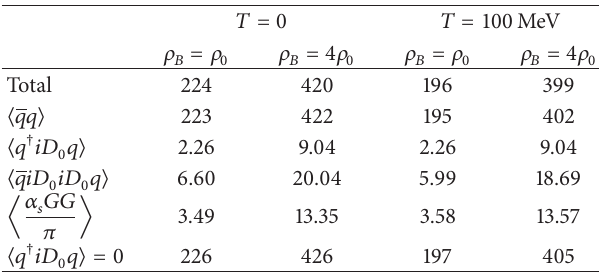
Table 1: The following table gives the values of mass shift of scalar mesons 𝐵 0 (in MeV units) due to individual condensates at temperatures 𝑇 = 0 and 100MeV. For each value of temperature the values are tabulated for baryon densities 𝜌 𝐵 = 𝜌 0 and 4𝜌 0 .